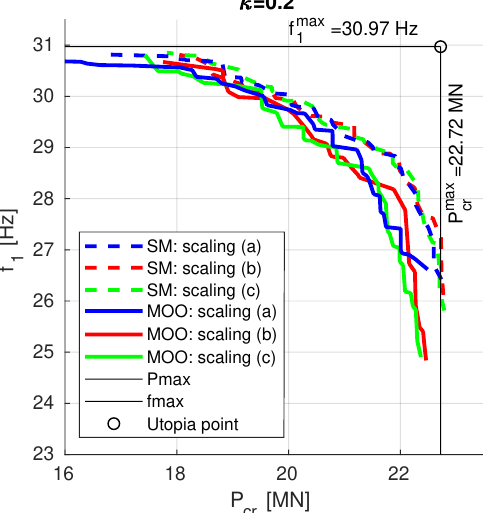
Figure 11. The final PFs obtained from MOO (continuous lines) and SM (dashed lines) optimization.